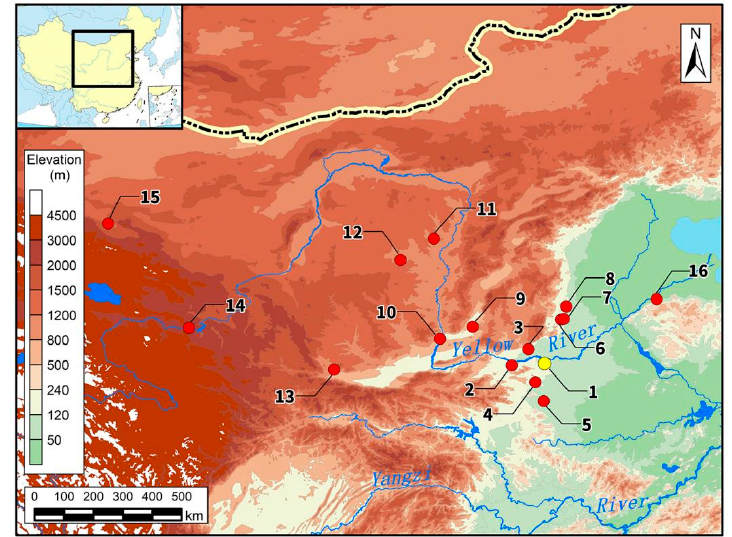
Figure 2. Location of Zhengzhou Shang City and other related archaeological sites. (1) Zhengzhou Shang City; (2) Erlitou; (3) Fucheng; (4) Wadian; (5) Jiahu; (6) Zhangdeng; (7) Xiaomintun; (8) Nancheng; (9) Taosi; (10) Ruiguo; (11) Shimao; (12) Jiadamao; (13) Xuechi; (14) Lajia; (15) Heishuiguo; and (16) Daxinzhuang.